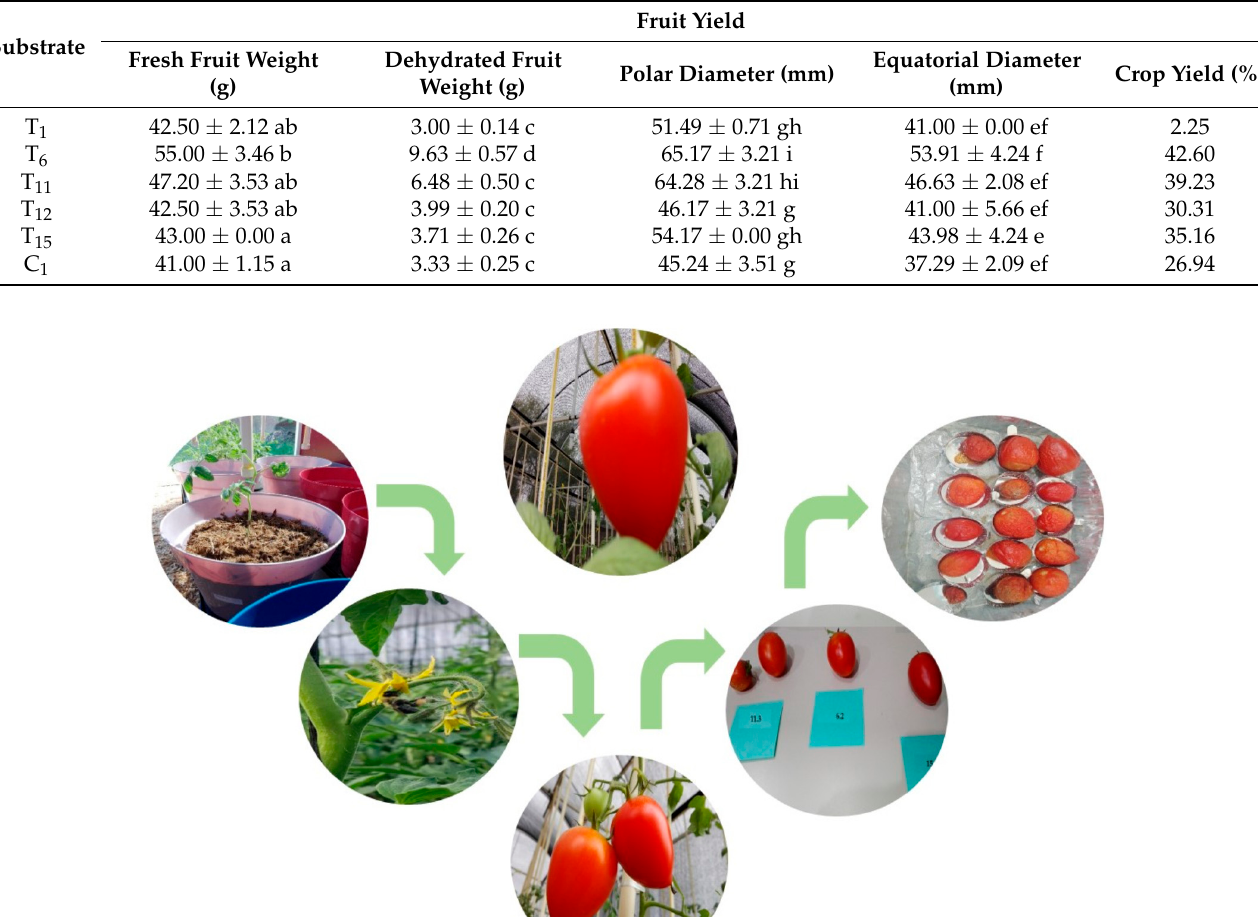
Table 4. Effect of the substrate composition on fruit quality. Different letters after means indicate significant differences at p ≤ 0.05 (Tukey´s HSD test).